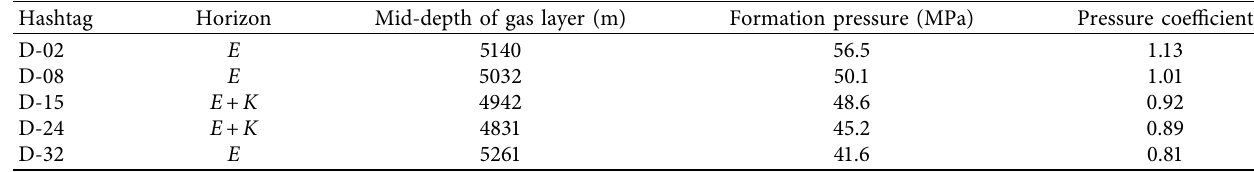
Table 2: Pressure measurement coefcients of reservoir sections in the study area.